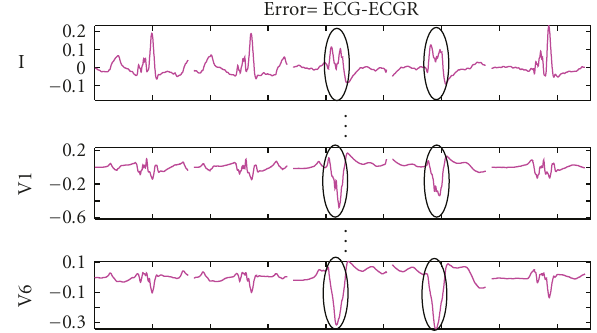
Figure 14: Example of a patient with cardiac arrhythmia: recon- struction